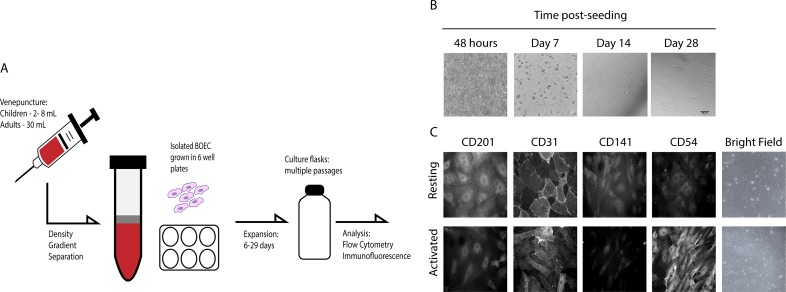
Establishing Blood Outgrowth Endothelial Cell (BOEC) lines from peripheral blood samples.(A) Process of isolating BOECs from human blood samples. B) Bright field images showing 48 hours post-seeding and documenting the appearance of progenitors (black arrow, day 7), small colonies (white arrow, day 14) and confluent BOEC (day 28) over time. C) Receptor expression (CD201/EPCR; PECAM-1/CD31; thrombomodulin/CD141 and CD54/ICAM-1) on resting and activated BOECs at passage 3. Shown is a representative immunofluorescence image (400 times magnification at passage 3) from a single donor. Bright field image (200 times magnification) shows elongation of cells after TNFα treatment.